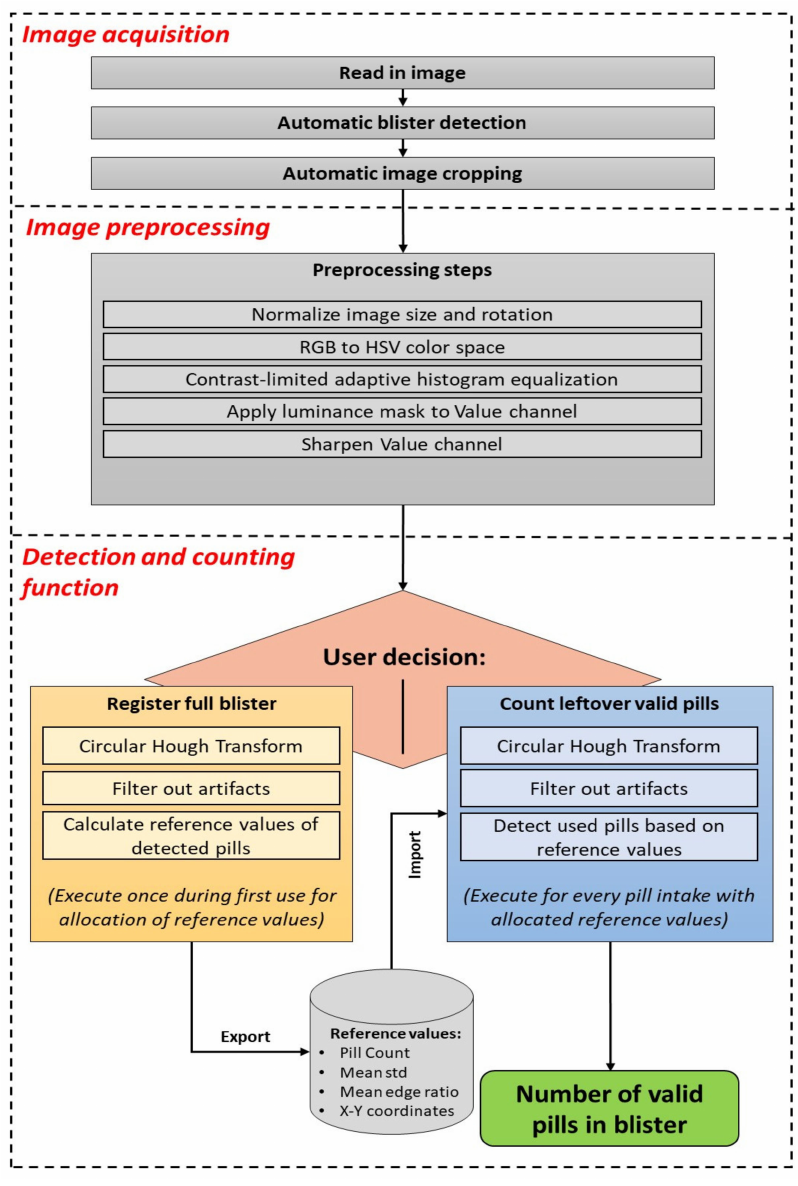
Figure 1. Pill detection tool